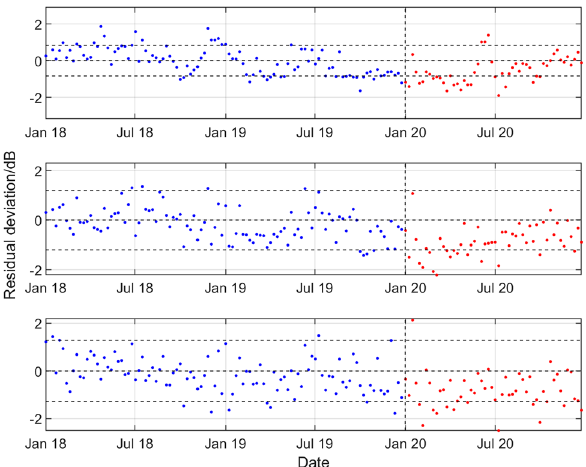
Figure 10. Results for the northern triplet hydrophone H03N1 data recorded at the CTBT Juan Fernandez Islands station, statistical level P 10 and (top to bottom) low, medium, and high frequency bands. For the period January 2018 to December 2019 and during 2020, deviations of the observed weekly SPSDL data from the predictable part of the signal defined by the long-term and medium-term seasonal components of the GP model.